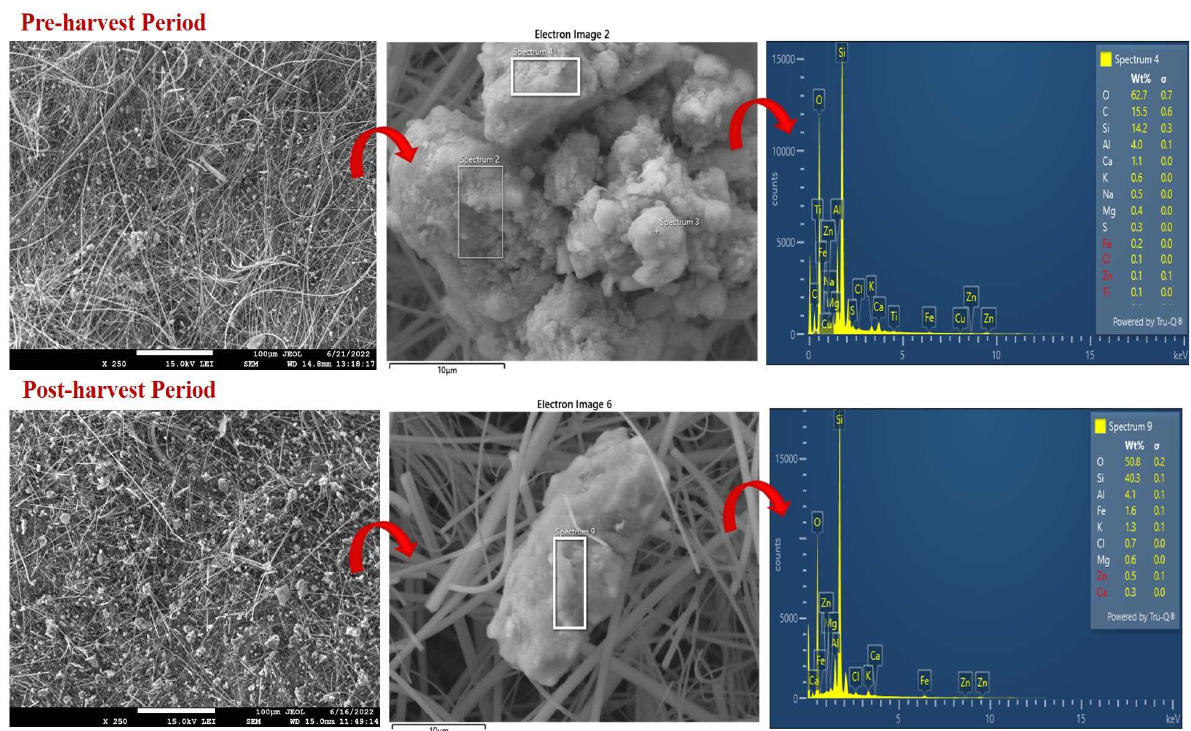
Figure 9. FESEM-EDX images of PM 2.5 filter papers during the pre-harvest and post-harvest crop residue burning events.